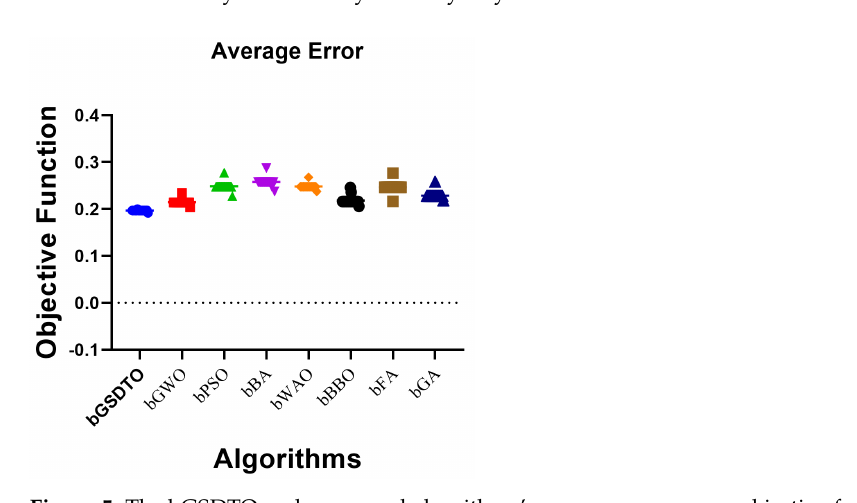
Figure 5. The bGSDTO and compared algorithms’ average error versus objective